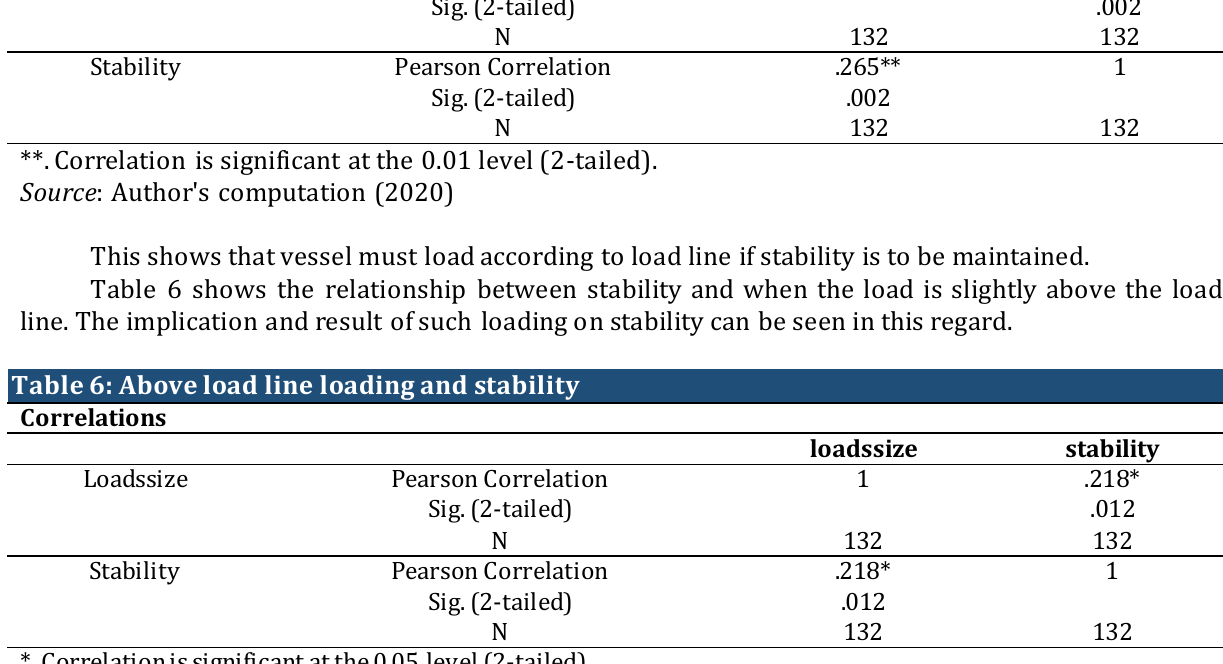
Table 5: load size and vessel's stability using load line Correlations Loadssize Pearson Correlation 1 .265** Stability Pearson Correlation